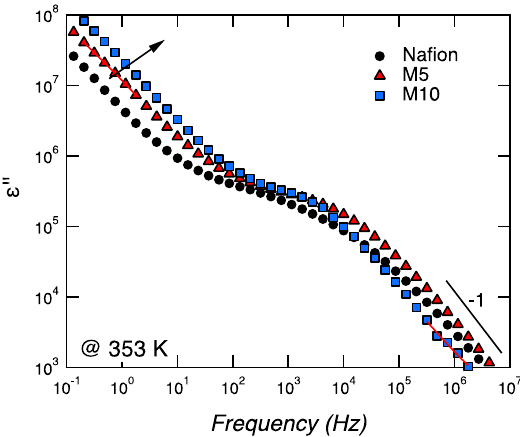
Figure 6. Frequency dependence of the imaginary part of the permittivity for Nafion, M5, and M10, at a given temperature of 80 °C, during heating.